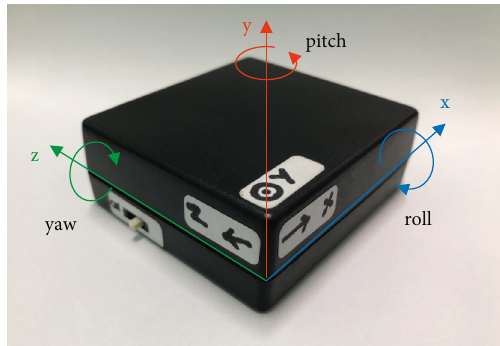
Figure 2: Developed prototype of the triaxial inertial sensor.